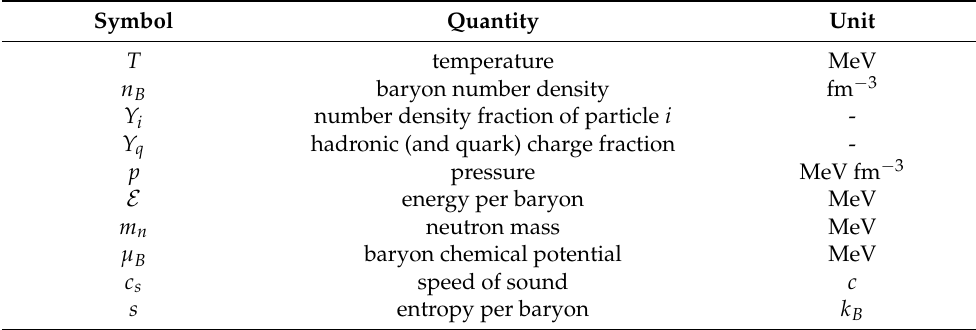
Table A1. Notations used in the Quick